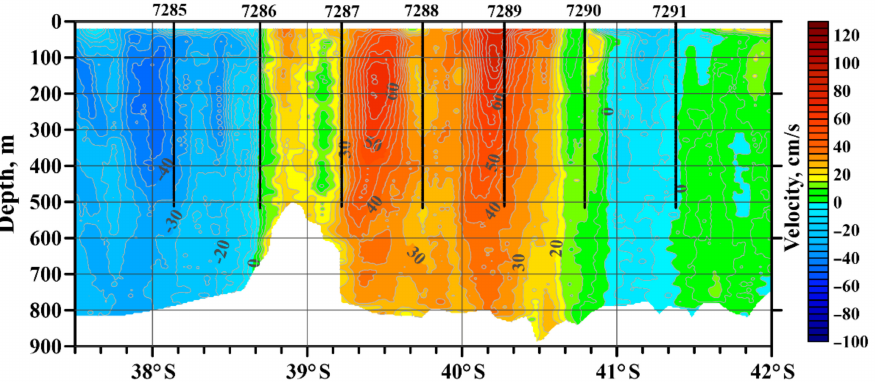
Figure 5. Velocity section across the rings based on SADCP measurements. Locations of stations are shown by thick black lines.